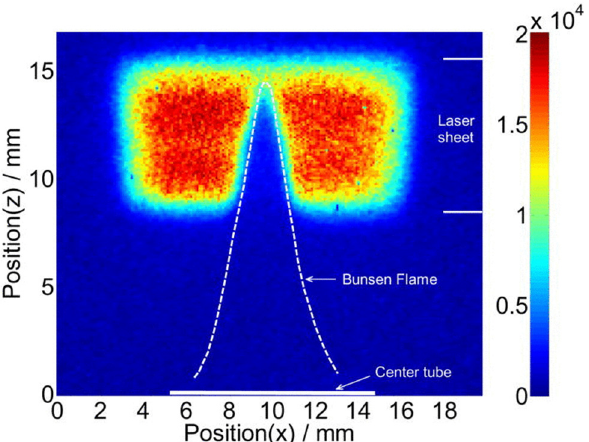
Figure 14. Two-dimensional distribution of particle-phase Ti imaged with a 500 nm bandpass filter, showing the rapid conversion from gas-phase precursor to TiO2 nanoparticles across the flame and conservation of particle volume fraction in the coagulation process downstream of the flame [191]. Reproduced with permission from Zhang, Y. et al., Applied Physics Letters; published by AIP Publishing, 2014.